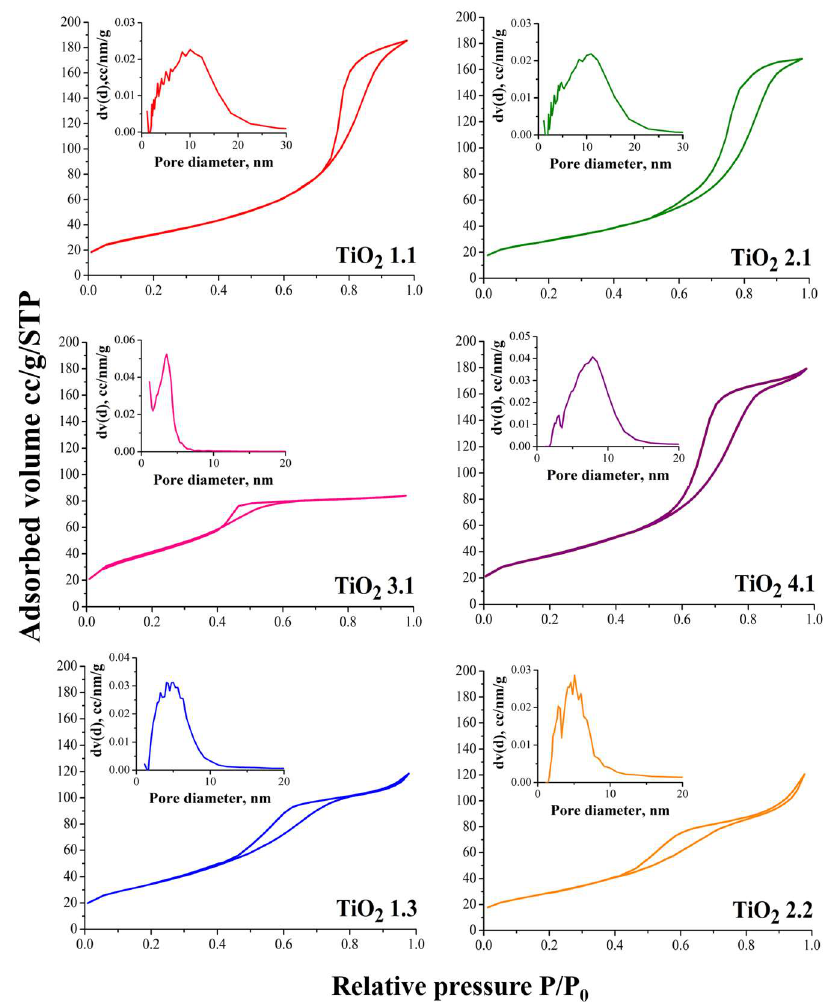
Figure 3. Nitrogen adsorption-desorption isotherms and corresponding BJH pore size distributions (insets) of the synthesized titania materials.